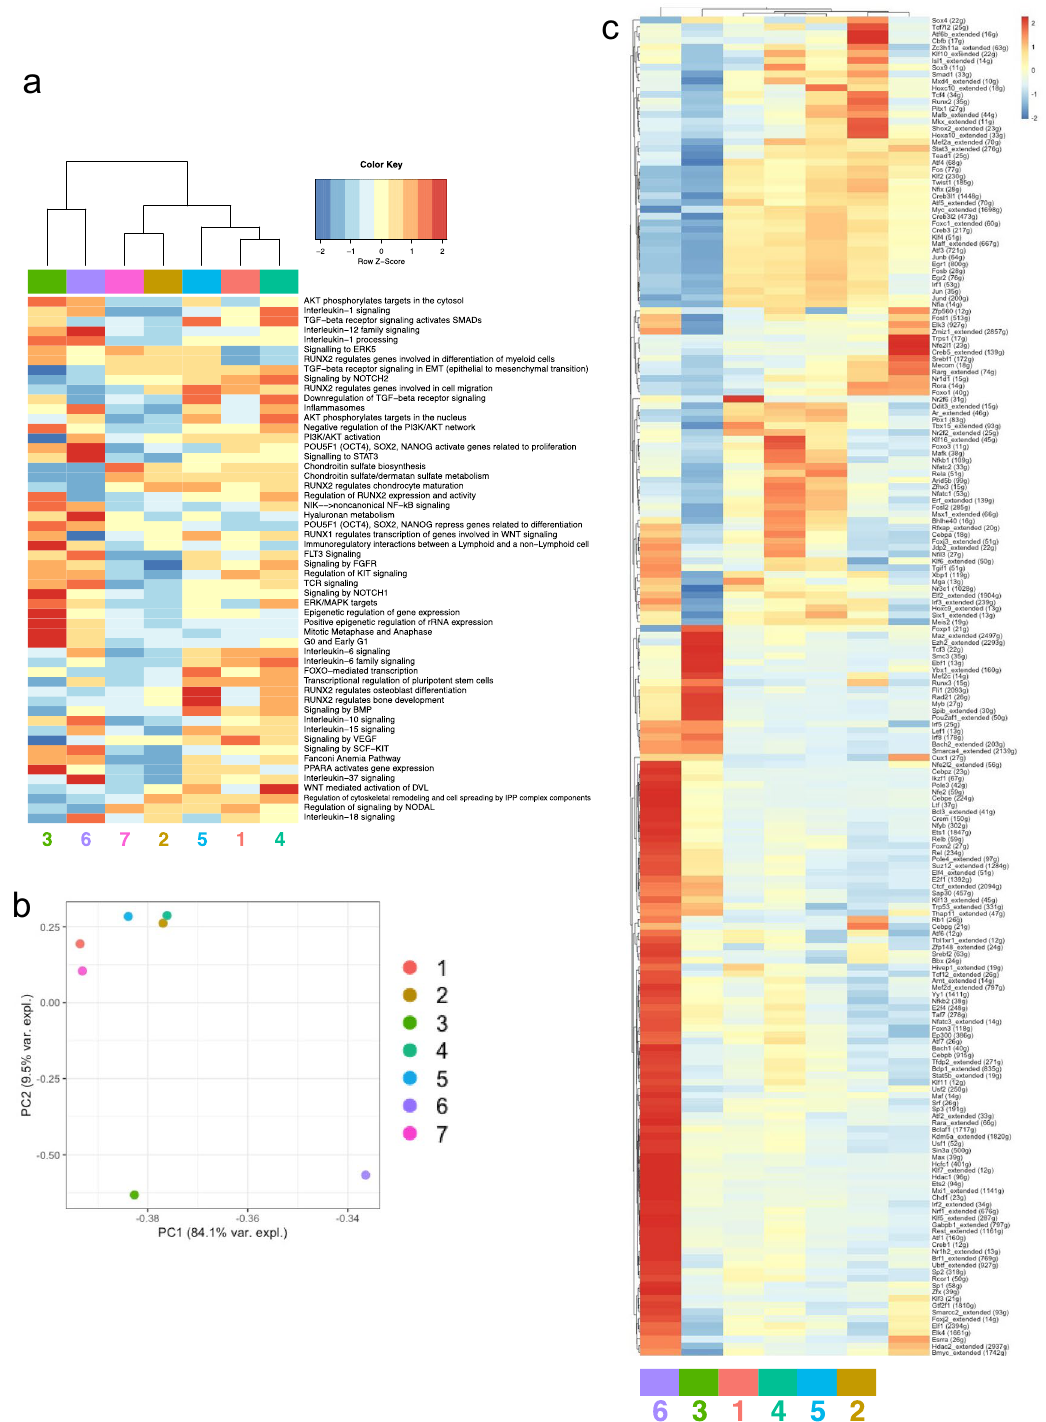
Figure 2. Down-stream analyses of scRNA-seq for the Pα-S fraction cells (n = 2367). Downstream analysis of cluster annotation in Fig. 1. ( a ) Heatmap of pathway enrichment comparing among clusters by ReactomeGSA. Comparison with the enriched pathways between each cluster. ( b ) Principle component analysis of enriched pathways in clusters. ( c ) Heatmap of regulatory transcriptional factors by SCENIC (color code as in Fig.